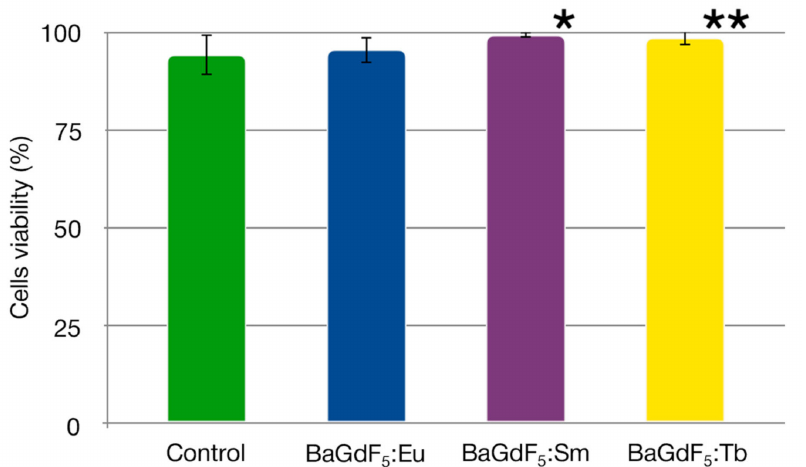
Figure 7. Viability of HeLa cells (%) in the control group and after exposure to synthesized nanoagents with the final concentration of 50 µ g/mL for 24 h. The error bars correspond to the standard deviation. *— p = 0.011, **— p = 0.051 (compared to the control